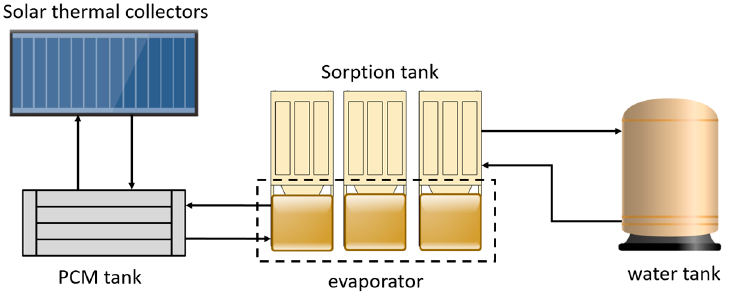
Figure 6. Connection between subsystems: collectors, PCM tank, sorption tank, and water tank. To obtain the optimal configuration of the theoretical PCM tank, the number of slabs per column and number of columns in series (meaning that the total length of the TES would be the slab length multiplied by the number of columns in series) were optimized based on the discharging process of the PCM tank. Moreover, two different types of PCM slabs containing the same PCM but with two different thickness were analyzed in the